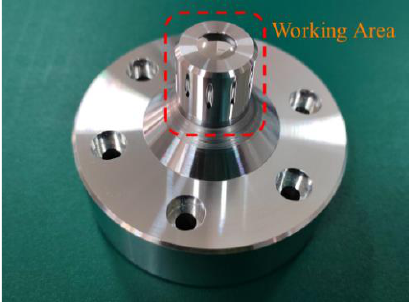
Figure 8. Standard workpiece.